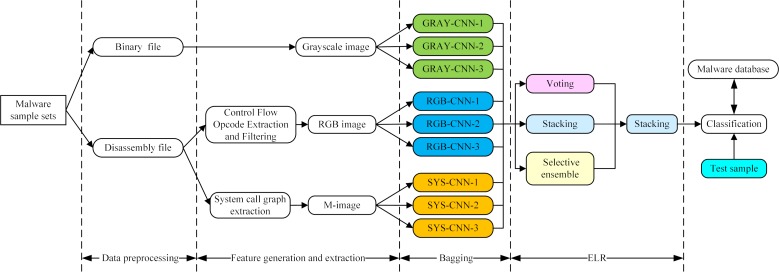
Overview of MHAS.